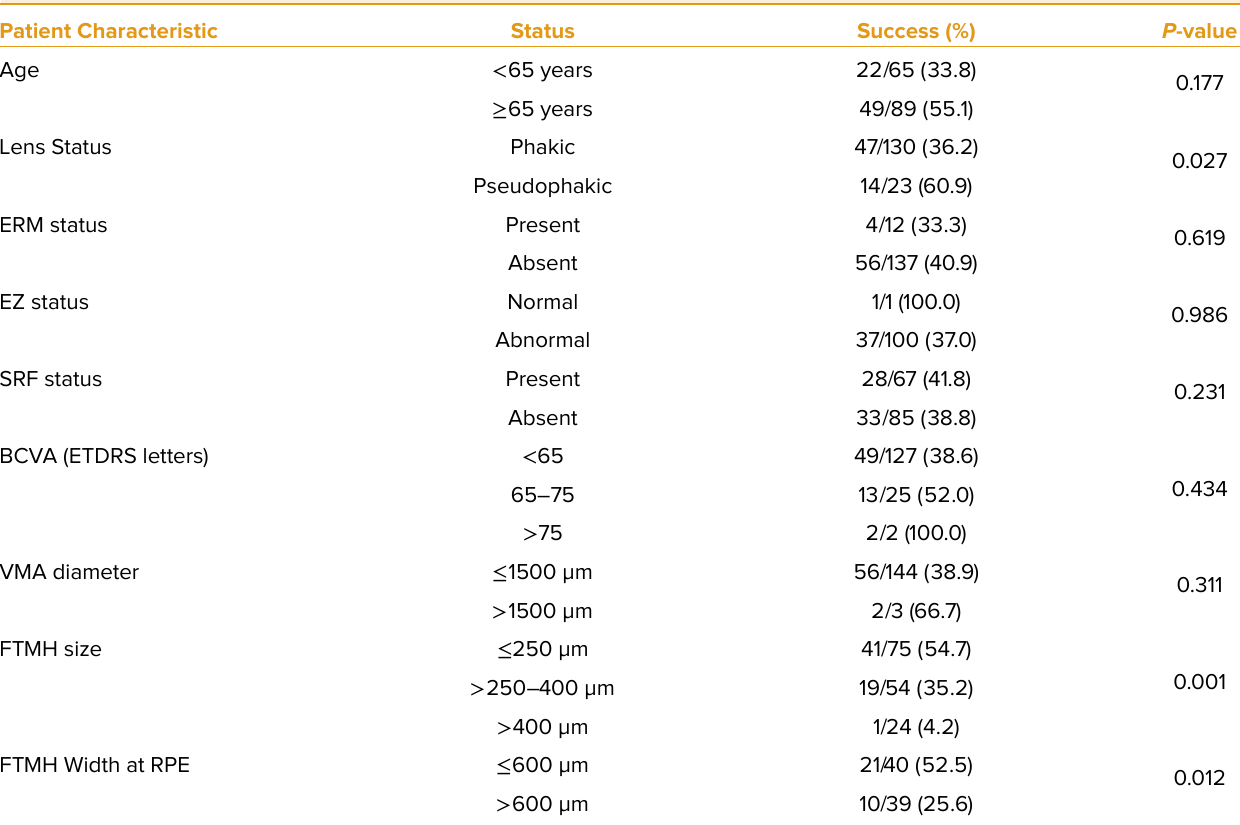
Table 4. univariable logistic regression analysis for the effect of patient demographics and ocular baseline characteristics on FTMH closure by Month 6 for patients with VMA resolution by Day 28 in the integrated dataset Patient